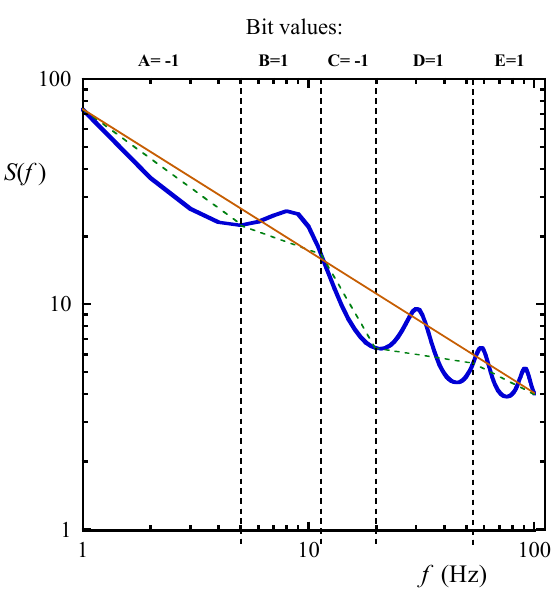
Figure 2. Generating the binary fingerprints [23]. The local slope (green dashed lines) of the spectrum (blue solid line) is compared with the global slope (red solid line). The bit values are − 1 (bits A, C) and 1 (bits B, D, E) depending on the result of this comparison.